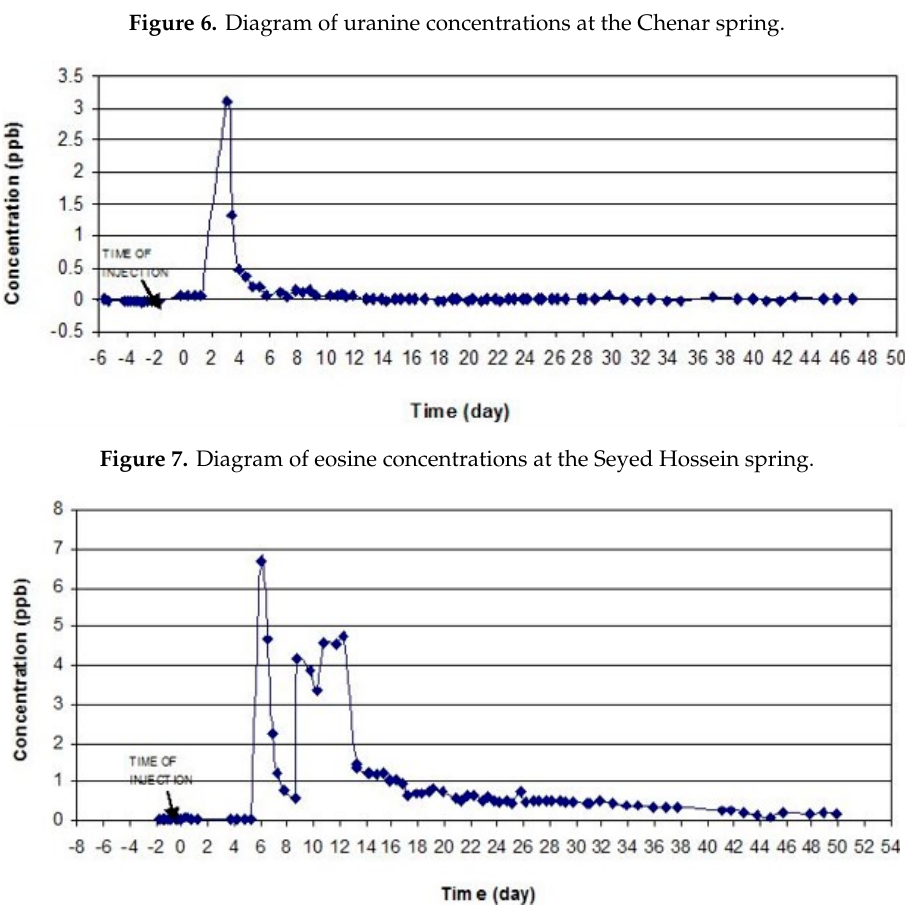
Figure 8. Diagram of uranine concentrations at the Seyed Hossein spring.